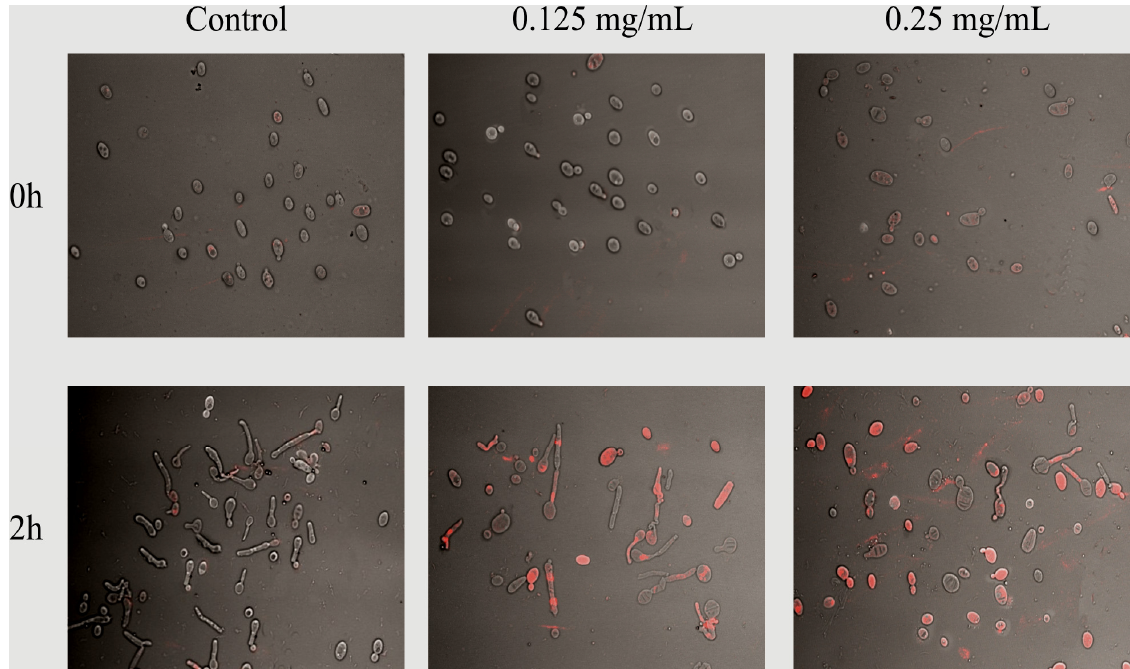
Figure 2. C. albicans control and T. alexandrinum SAPF—treated cells (at concentration of 0.125, 0.25 mg/mL) stained after 0 and 2 h of co-incubation with propidium iodide (60 µM). Undamaged cells (gray/transparent) and the cells with impaired cell wall permeability (red) were determined using a Confocal Laser Scanning Microscope (PI fluorescence detected at the excitation of 543 nm). The presented images are representative from two independent